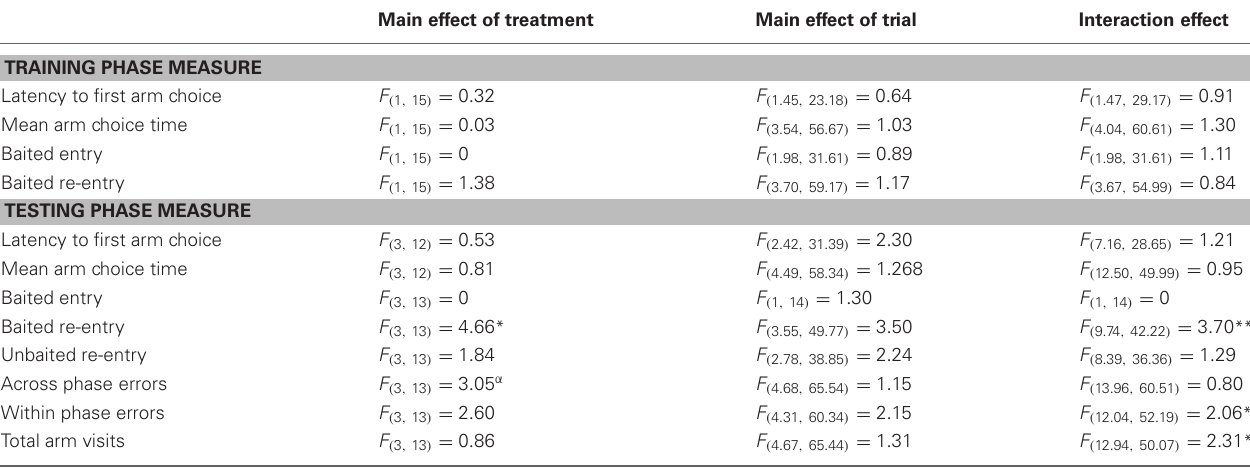
Table 4 | Results of 1 within (TRIAL), 1 between (TREATMENT) ANCOVA for the 6h DSWT, with performance at the 3h delay as a fixed covariate.